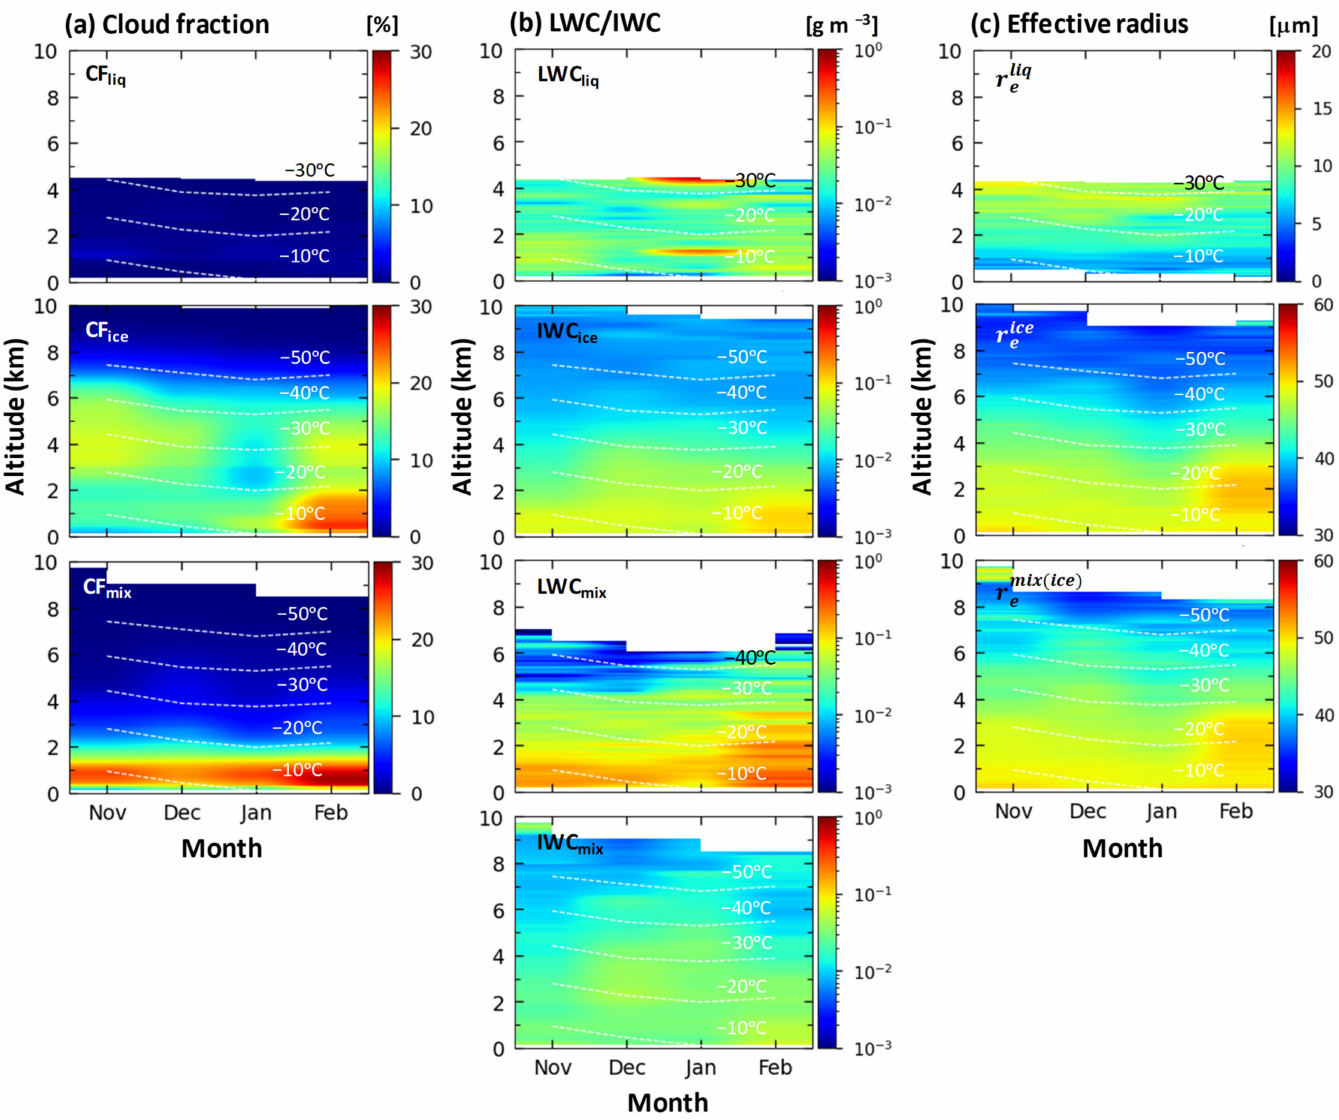
Figure 1. Monthly mean vertical distributions of ( a ) cloud fraction (CF), ( b ) liquid and ice water content (LWC/IWC), and ( c ) effective radius ( r e ) for liquid, ice, and mixed-phase clouds during winter months (November–February) at Ny-Ålesund. White horizontal dashed line indicates the model-derived isotherm with intervals of 10 ◦ C. Note that the ranges of r e between liquid droplets (0–20 µ m) and ice particles (30–60 µ m) in ( c ) are